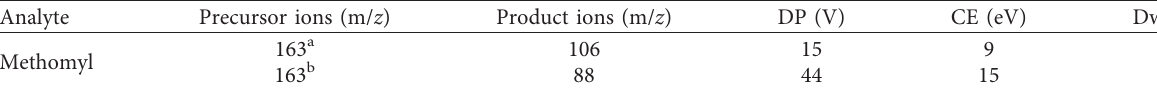
Table 2: MRM analysis ions of methomyl.